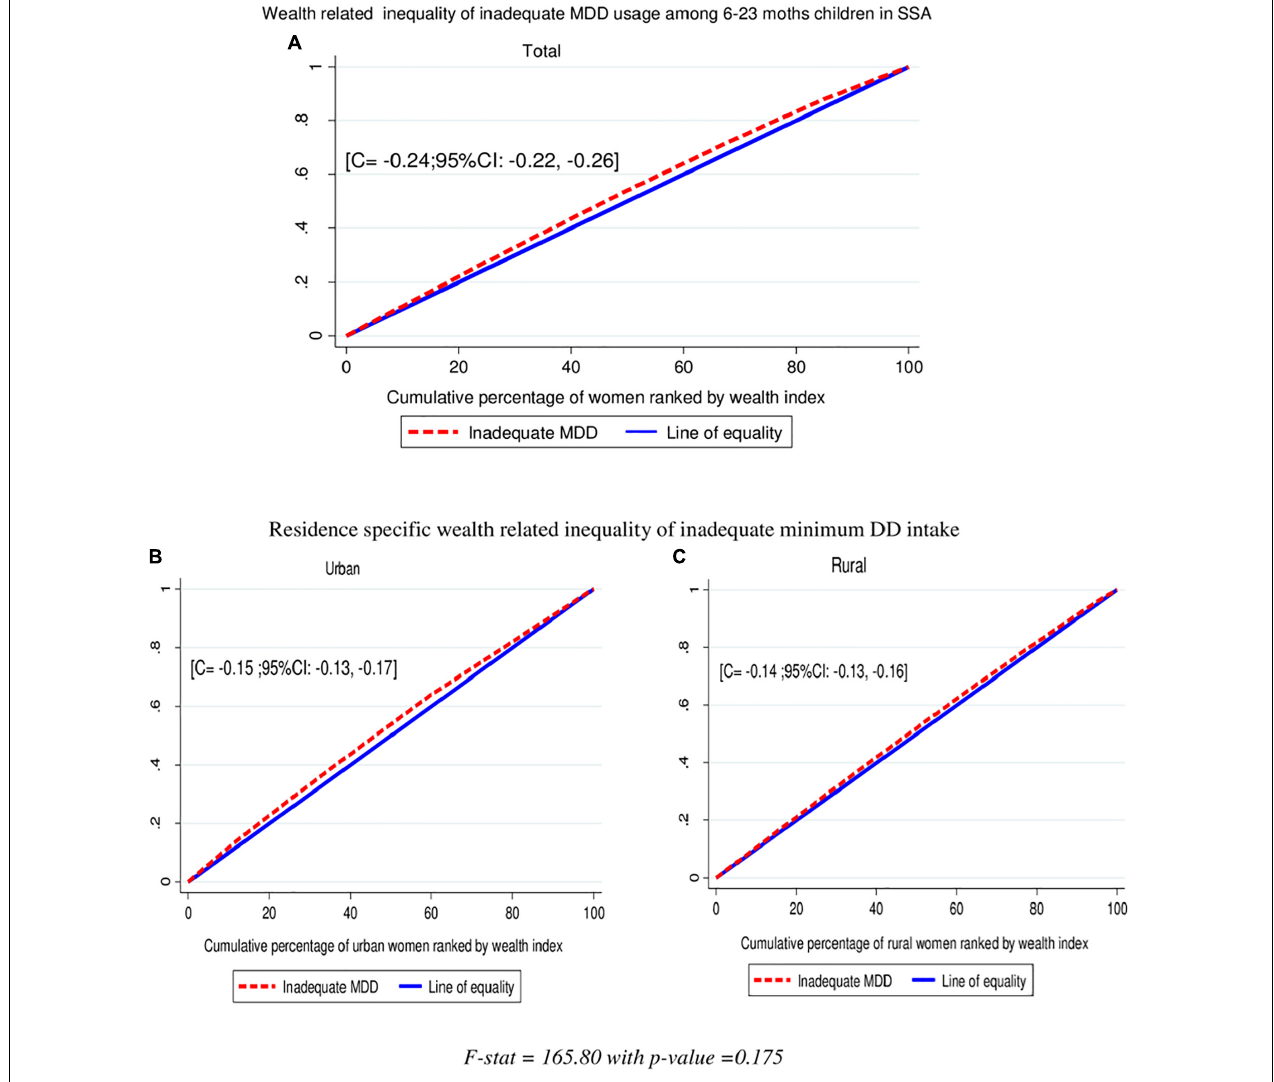
FIGURE 3 | Wealth-related inequalities of inadequate minimum DD intake total (A) , urban (B) , and rural (C) among children aged 6–23 months in